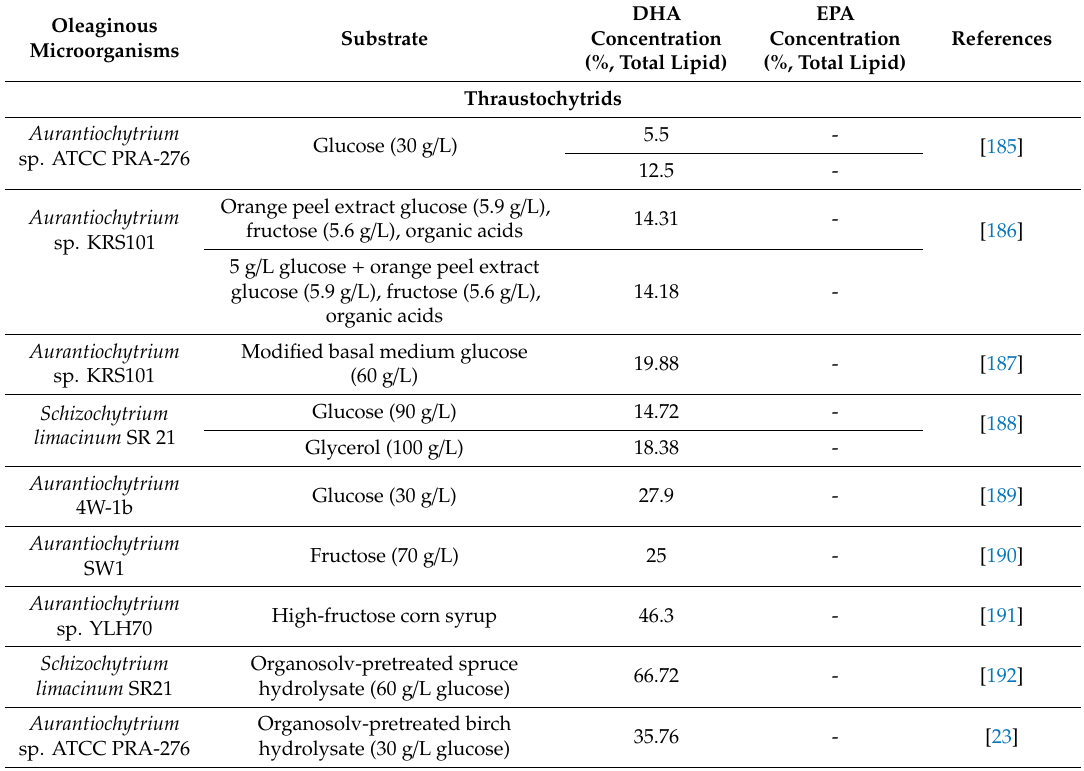
Table 2. A list of oleaginous microorganisms with their EPA and DHA